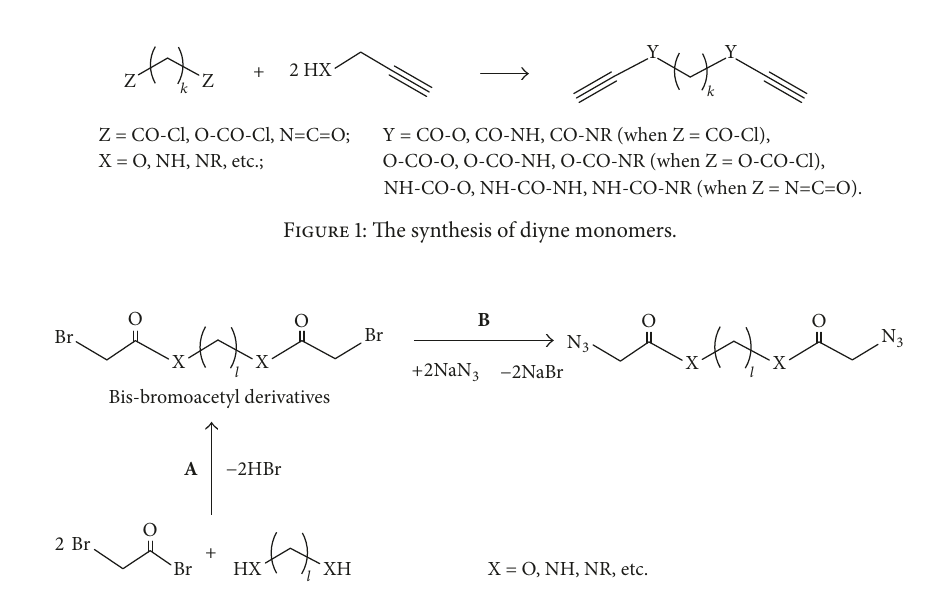
Figure 2: Synthesis of bis-bromoacetyl derivatives ( A ) and in situ generation of diazide monomers ( B